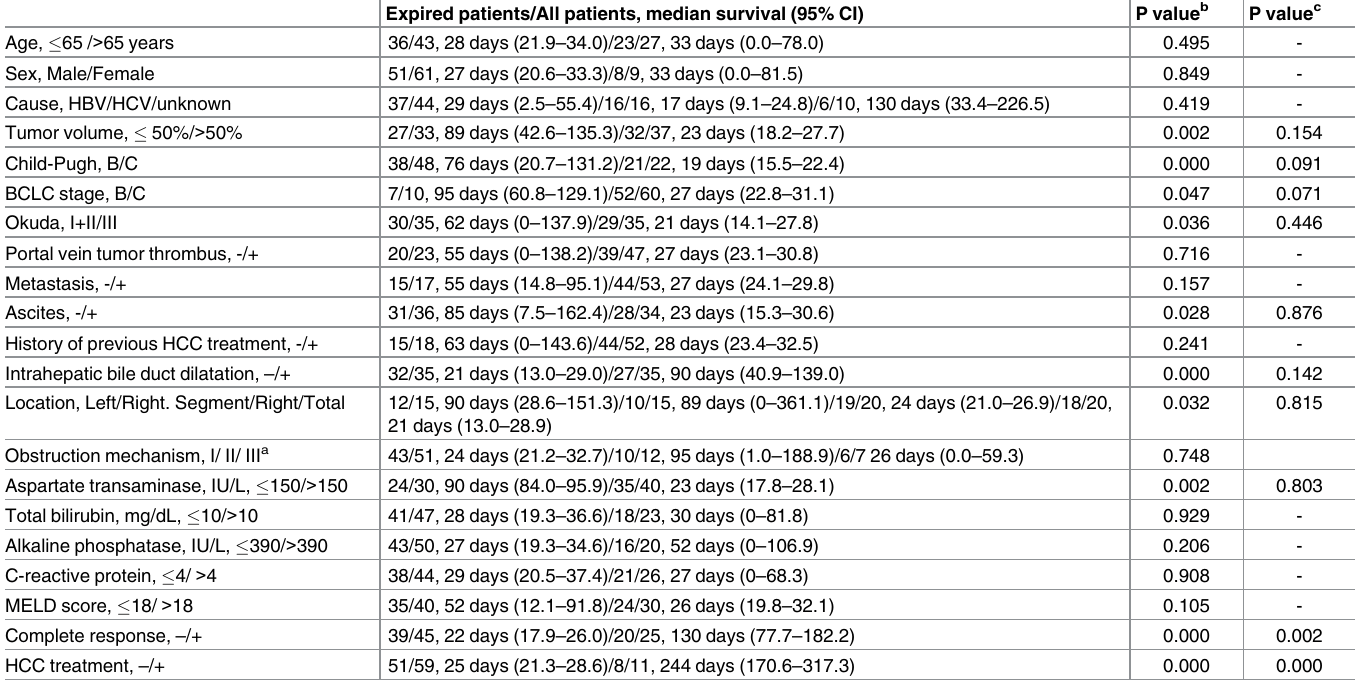
Table 4. Clinical factors associated with